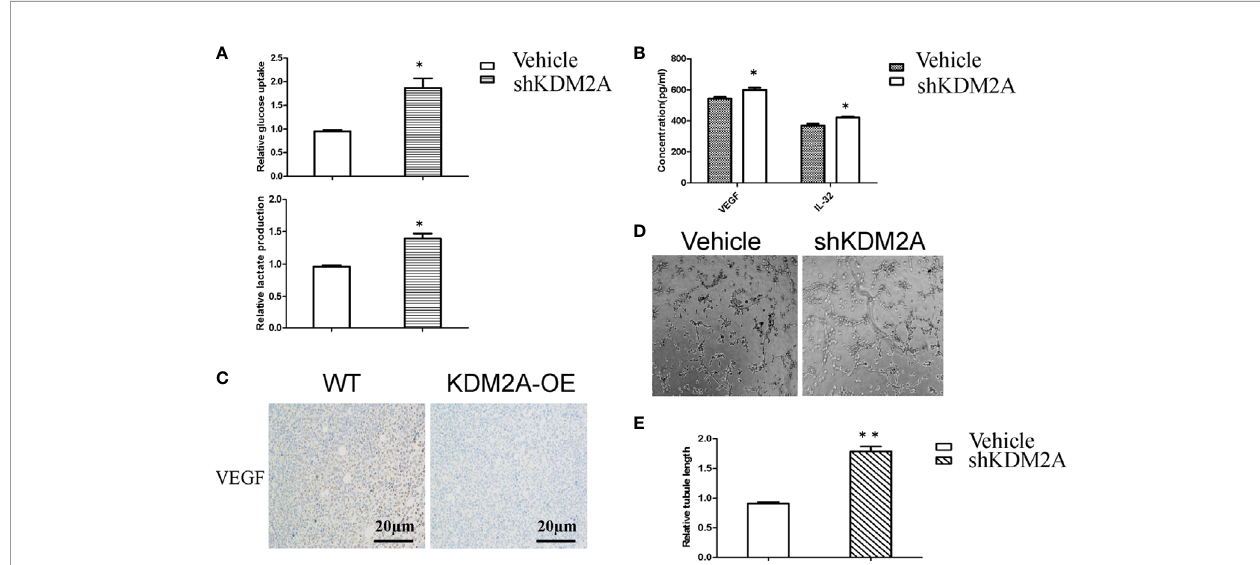
FIGURE 3 | shKDM2A promotes glycolysis activity and tube formation of HUVECs. (A) Glucose uptake and lactate production were detected in MM cells with shKDM2A as described in the Material and Methods using a glucose uptake assay kit and a lactate assay Kit.*P < 0.05. (B) ELISA assays showed that shKDM2A MM cells increased secretion of VEGF and IL-32 in culture medium. *P<0.05. (C) Representative IHC images for VEGF in the mice were shown (scale bar, 20 µm). (D) MM cells with shKDM2A culture medium enhanced tube formation ability in HUVECs seeded on Matrigel. Images were taken using a light microscope (×100). (E) The quantitative data of the tube formation assays. Quantitative data were from 3 independent experiments. *P < 0.05. The above representative results were veri fi ed in RPMI8226 cell